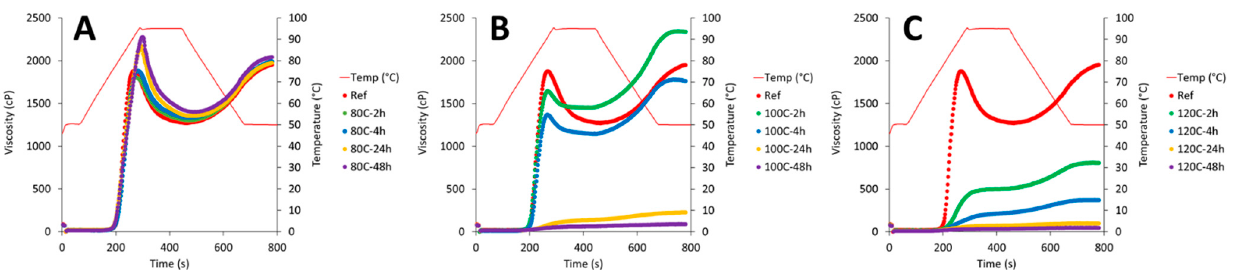
Figure 4. RVA pasting profiles of dry-heated CPF for temperature conditions of 80 °C ( A ), 100 °C ( B ) and 120 °C ( C ) following 2, 4, 24 and 48 h of treatment time. Profiles are compared to the native flour reference (Ref in red). Table 2. RVA pasting parameters of native and dry-heated CPF. For the dry-heated CPF samples, the temperature (C) and time (h) treatment conditions are indicated by the codes.